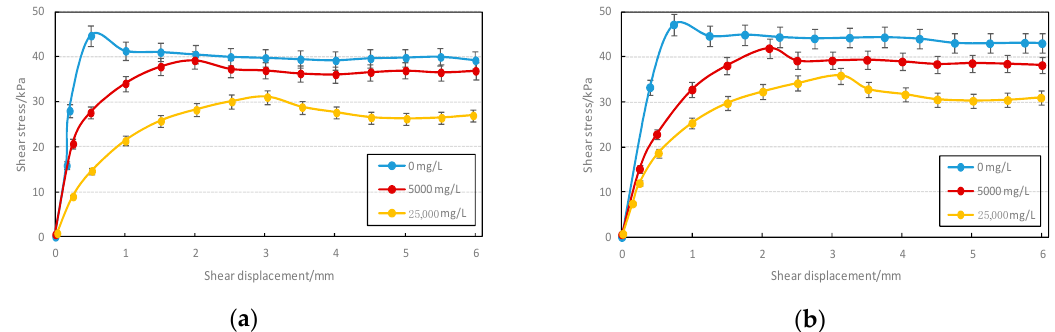
Figure 5. Shear stress vs. shear displacement curves of the FR ‐ CPB/rock interface (treated for 1 day; normal stress of 50 kPa). ( a ) CPB made with 0% fibers; ( b ) CPB made with 0.3% fibers.